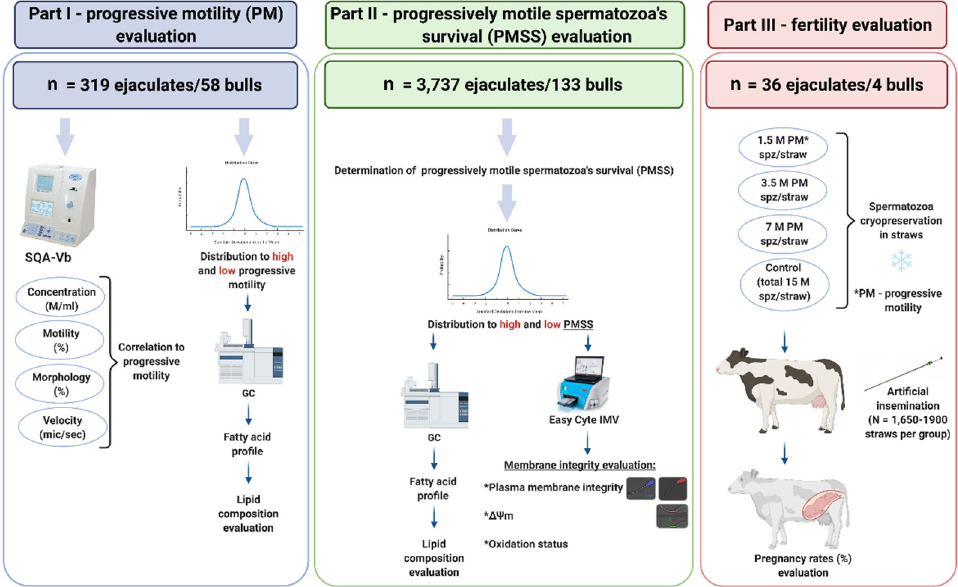
Figure 1. Schematic illustration of the experimental design. The study consisted of three parts: (1) a retrospective analysis of Sion Ltd.’s database to examine correlations between PM and physiological parameters. High-PM and low-PM thresholds were defined and the fatty acid composition were analyzed by GC; (2) based on Sion Ltd.’s database, the parameter of progressively motile spermatozoa’s survival (PMSS) was established, high-PMSS and low-PMSS thresholds were defined, and membrane fatty acid composition (GC) and integrity (FC) were analyzed; (3) a fertility study was conducted in which AI was performed with straws containing 15 M spermatozoa in total (control) or 1.5 M, 3.5 M or 7 M progressively motile spermatozoa per straw (PM spz/straw) after thawing.